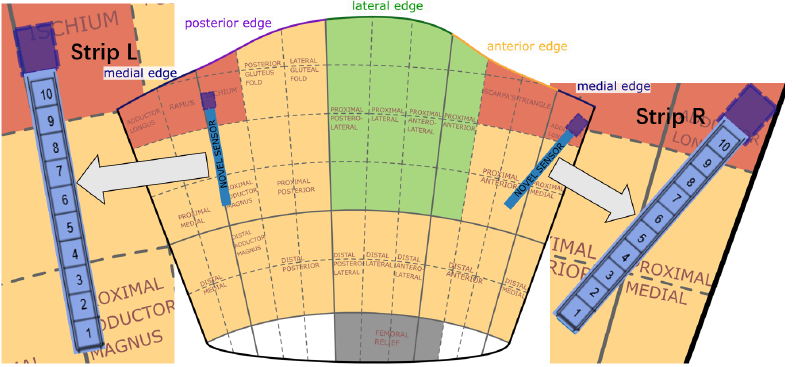
Figure 6. A 2D representation of a prosthetic socket with Novel [27] sensor placement (2 strips with 10 sensors on each strip) inside the socket.